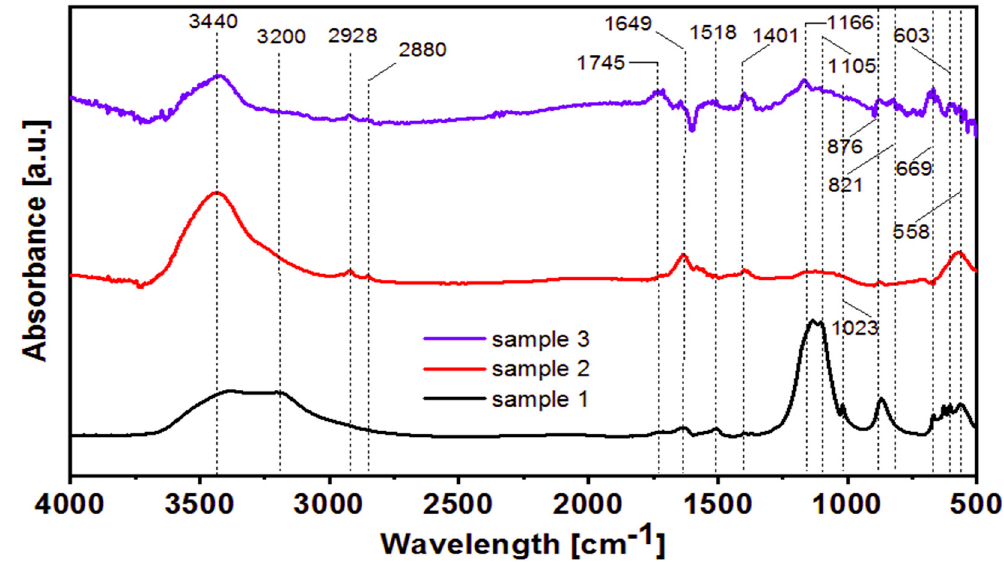
Figure 6. FT-IR spectra of battery waste powder for sample 1 that was leached with H 2 SO 4 and H 2 O 2 , sample 2 that was leached with H 2 SO 4 and C 5 H 8 O 4 , and sample 3 that was leached with H 2 SO 4 , C 5 H 8 O 4 and H 2 O 2